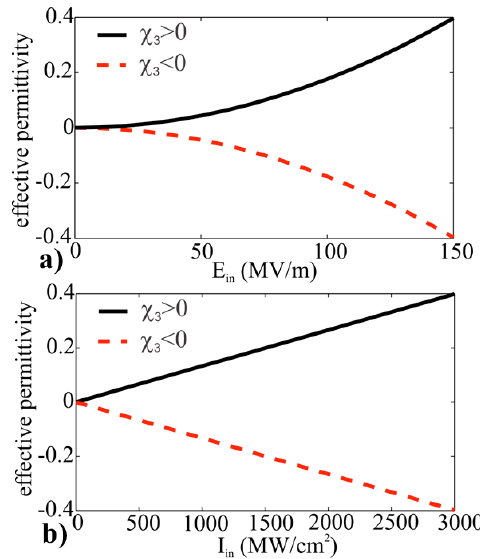
Figure 2: The effective permittivity of an artificial nonlinear ENZ metamaterial as in Fig. 1, as a function of: (a) the input electric field and (b) the input optical intensity. Positive values of effective permittivity are obtained for focusing nonlinearities (3) (black solid lines) and negative values for defocusing nonlinearities (red dashed lines) for both